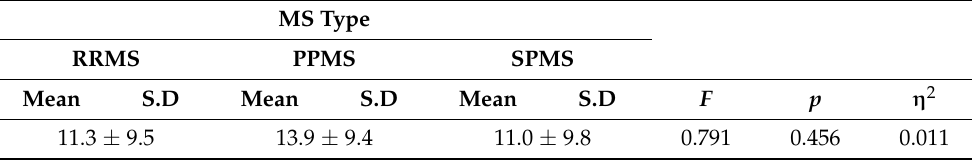
Table 7. Absolute percentage differences in the estimation between the 1RM value and 1RM_all by MS type.